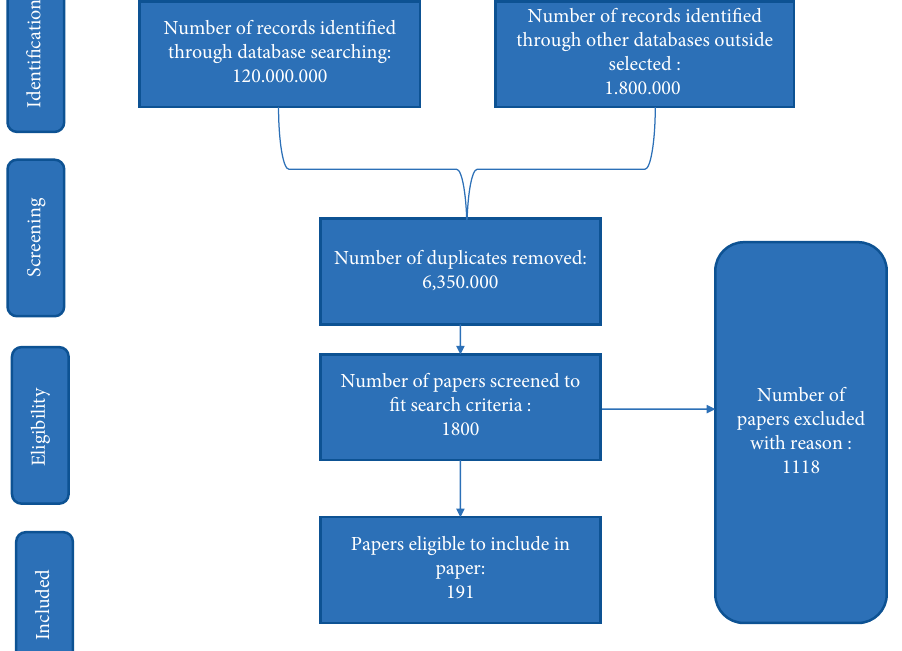
Figure 1: Search